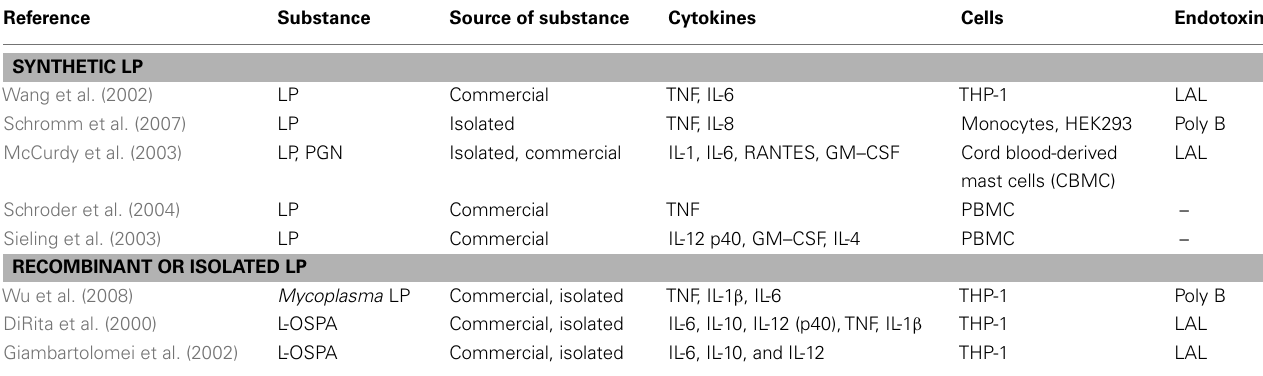
Table 6 | Publications after fulfillment of decision tree for K/D criterion 3 for synthetic LP and recombinant or isolated